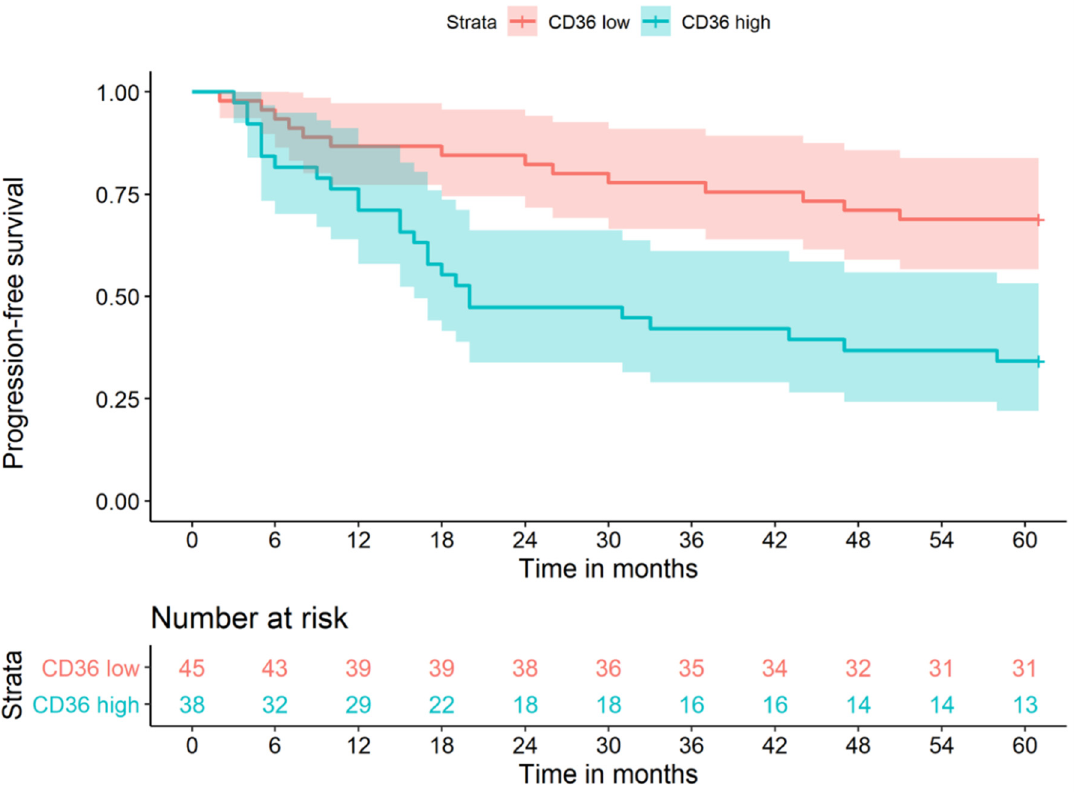
Figure 2. Progression-free survival low CD36 vs. high CD36 expression. Table 5. Results of Cox regression model for progression-free